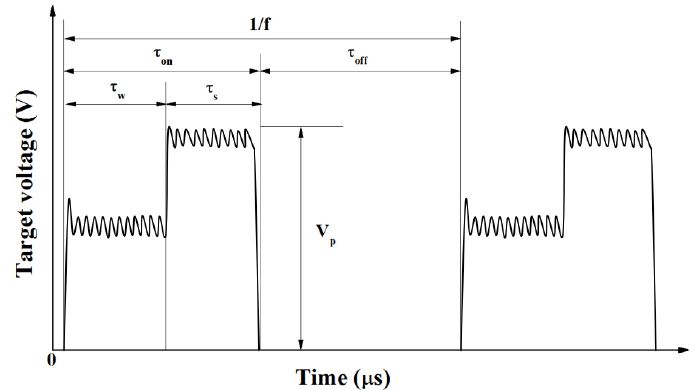
pulses increased (Table 1). To keep fixed the average power, the frequency of the power pulses changed